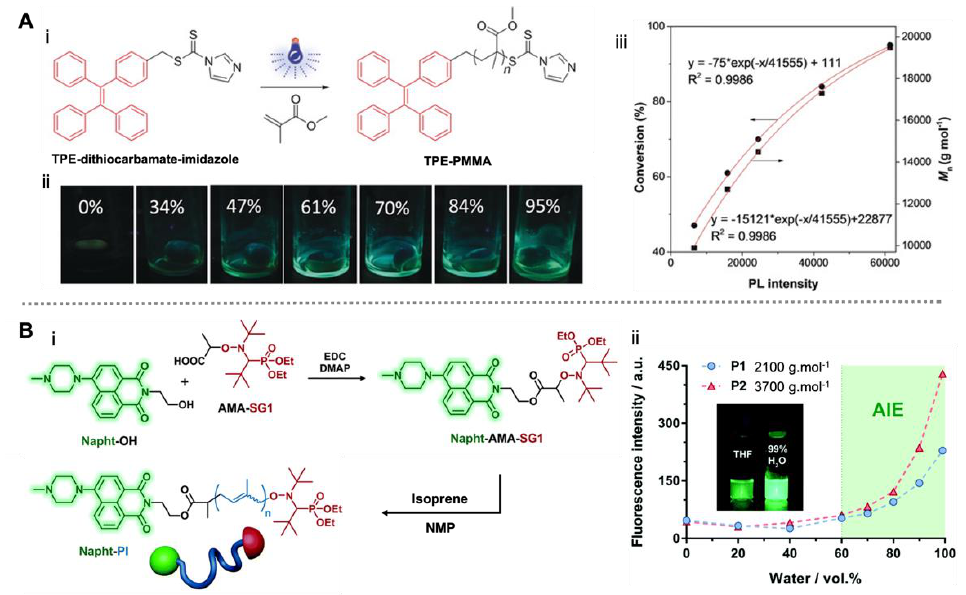
Figure 3. Single-fluorophore AIE polymers prepared by RAFT polymerization and NMP. ( A ) Illustration of RAFT polymerization (i) and photographs of the polymer solutions at different conversions under UV irradiation (ii), as well as the exponential relationship of conversion and M n with emission intensity (iii). Reproduced with permission from [57], copyright 2018, John Wiley and Sons, Inc. ( B ) Illustration of NMP synthesis (i) and the AIE activity of the resulting polymers (ii). Reproduced with permission from [60], copyright 2017, Royal Society of Chemistry.